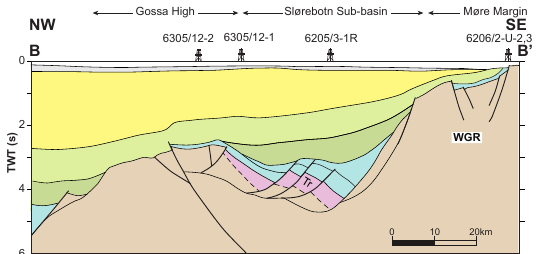
Figure 6. Geoseismic profile across the southeast Møre Basin. From Blystad et al. (1995). Location of profile in Fig. 3. Jurassic sediments (blue colour), other colours as in Fig. 4. Wells are projected onto the